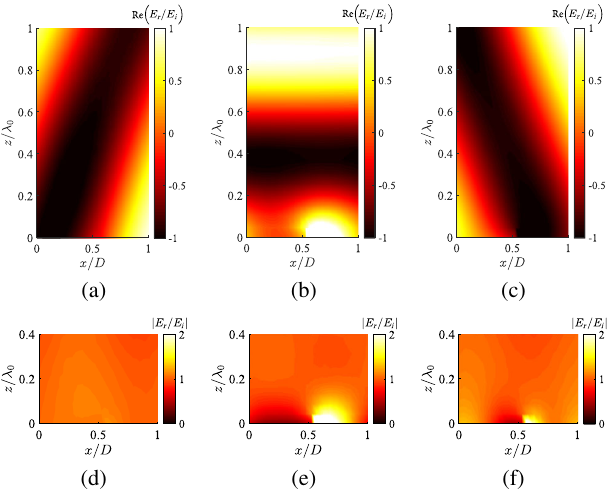
FIG. 4. Numerical simulations of the three-channel mirror modeled as an inhomogeneous sheet with surface impedance calculated from Eq. (5). Real part (instantaneous value) and magnitude of the scattered normalized electric field when the reflector is illuminated from port 3 [(a) and (d)], port 2 [(b) and (e)], and port 1 [(c) and